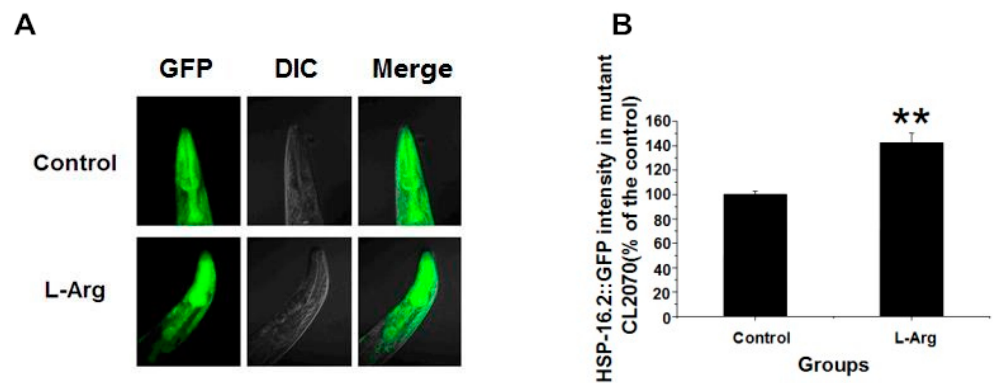
Figure 3. L-Arg upregulates HSP-16.2::GFP expression in CL2070 worms. ( A ) Images of HSP-16.2::GFP expression in control and L-Arg-treated worms; ( B ) Quantitative fluorescence analysis in transgenic CL2070 worms. Data are presented as the mean ± SE of four individual experiments, with 40 worms in each group (** p < 0.01).